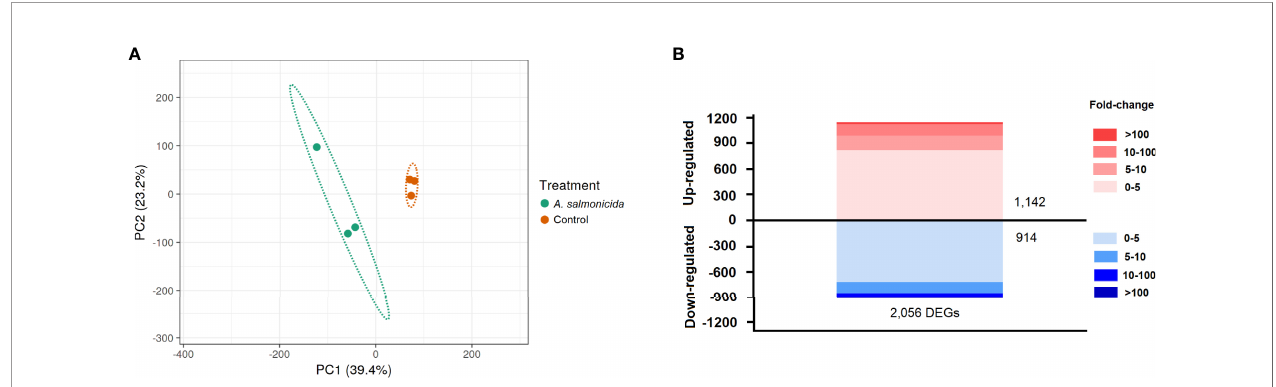
FIGURE 2 | RNA-Seq analysis of the head kidney transcriptome response to A salmonicida subsp. salmonicida infection in turbot. (A) Principal component analysis (PCA) of the samples. (B) Stacked column chart showing the number and intensity of the up- and downregulated DEGs after A salmonicida